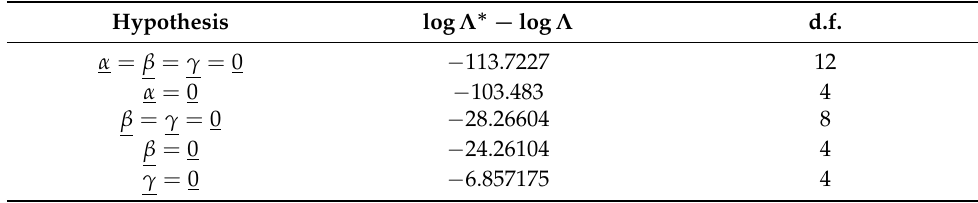
Table 3. Hypothesis testing for the Australian Health Service Utilization Data.